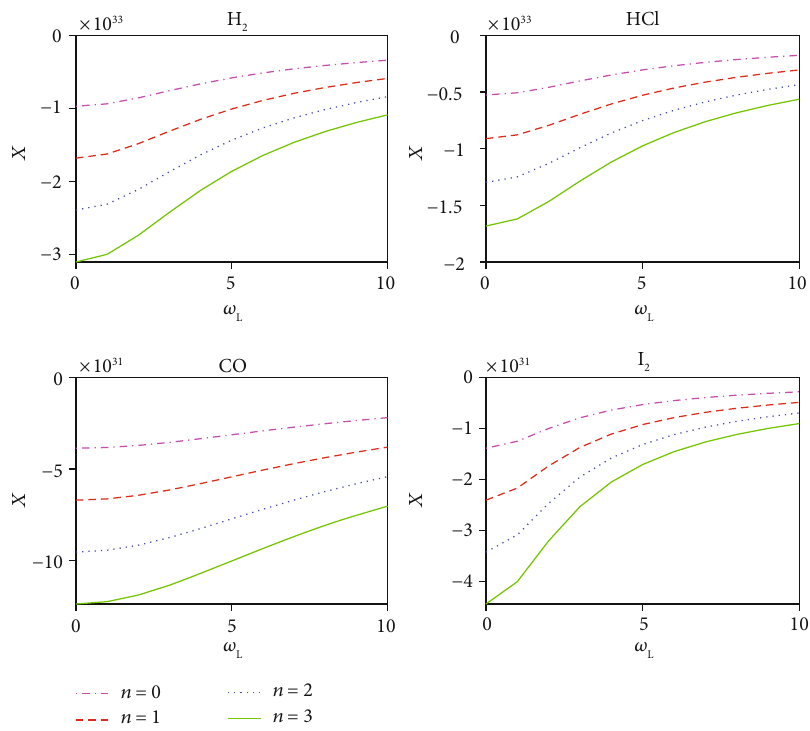
Figure 5: The diamagnetic susceptibilities X as a function of Larmor frequencies ω numbers of states n with g = m = z = e = 1 .